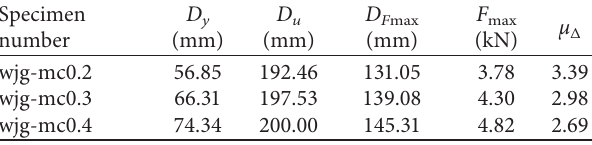
Table 9: Seismic performance index of group C models.